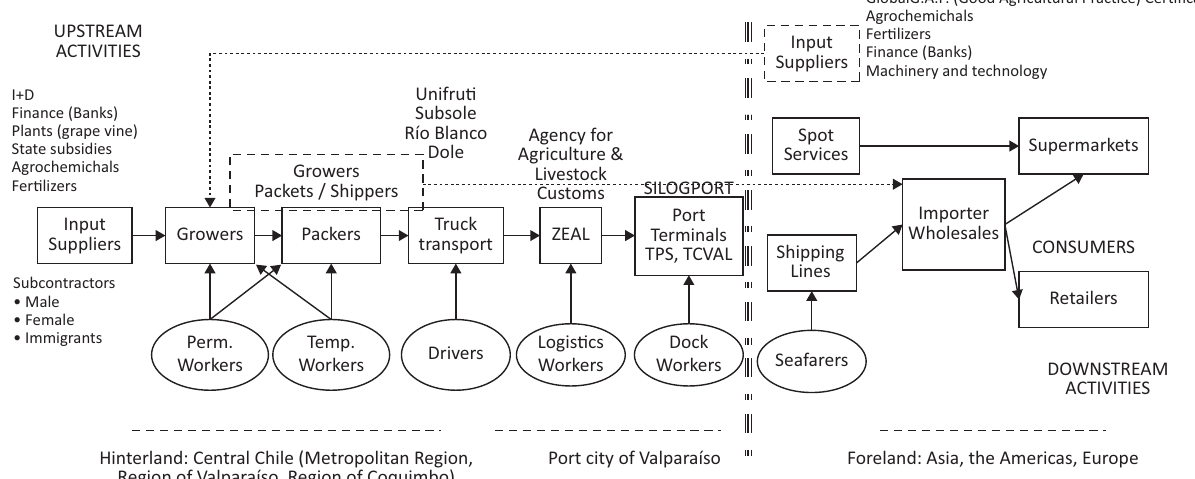
Figure 13. Global commodity chain of table grape. Source: Own elaboration based on Goldfrank (1994). Urban Planning, 2021, Volume 6, Issue 3, Pages